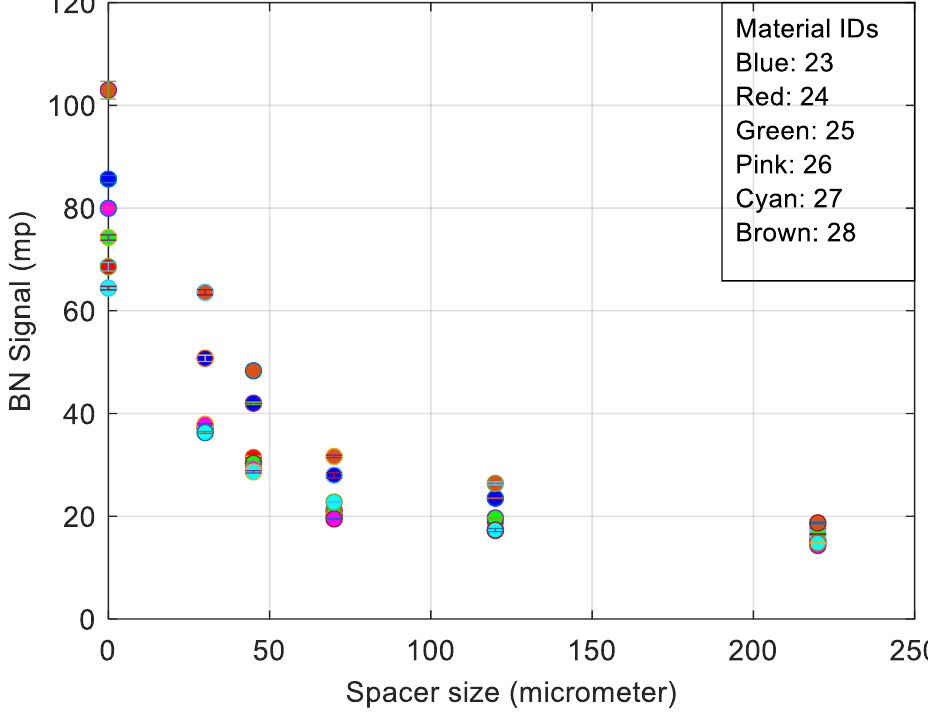
Figure 3. BN signal response for top surface in longitudinal orientation.